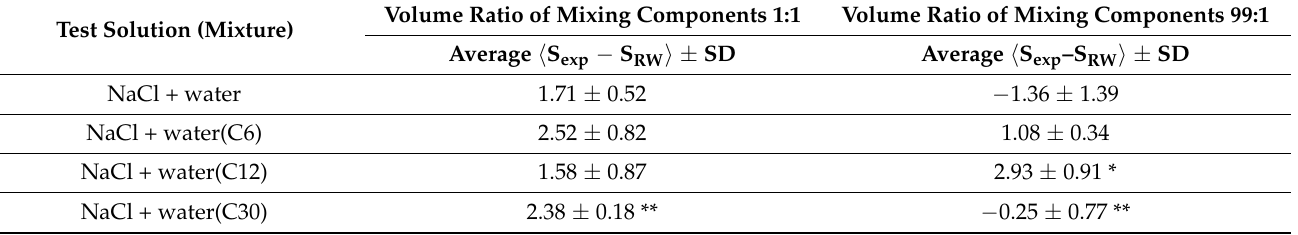
Table 2. Values of the (cid:104) S exp – S RW (cid:105) in the test